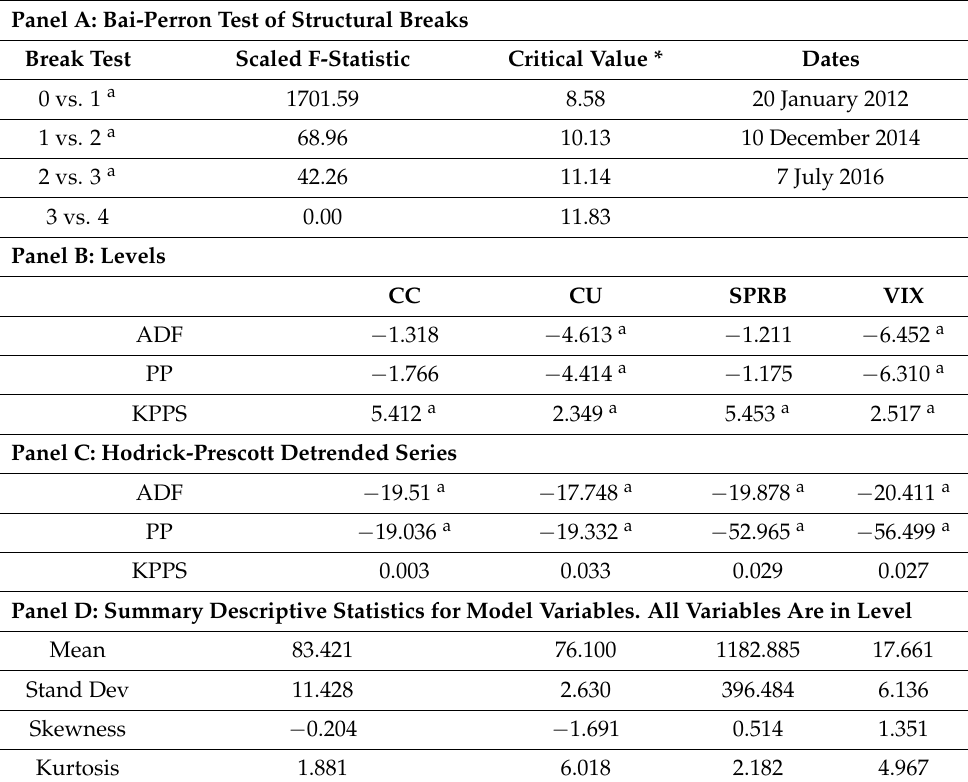
Table 1. Break points, diagnostics, and summary 30 April 2009–31 January 2019. Panel A: Bai-Perron Test of Structural